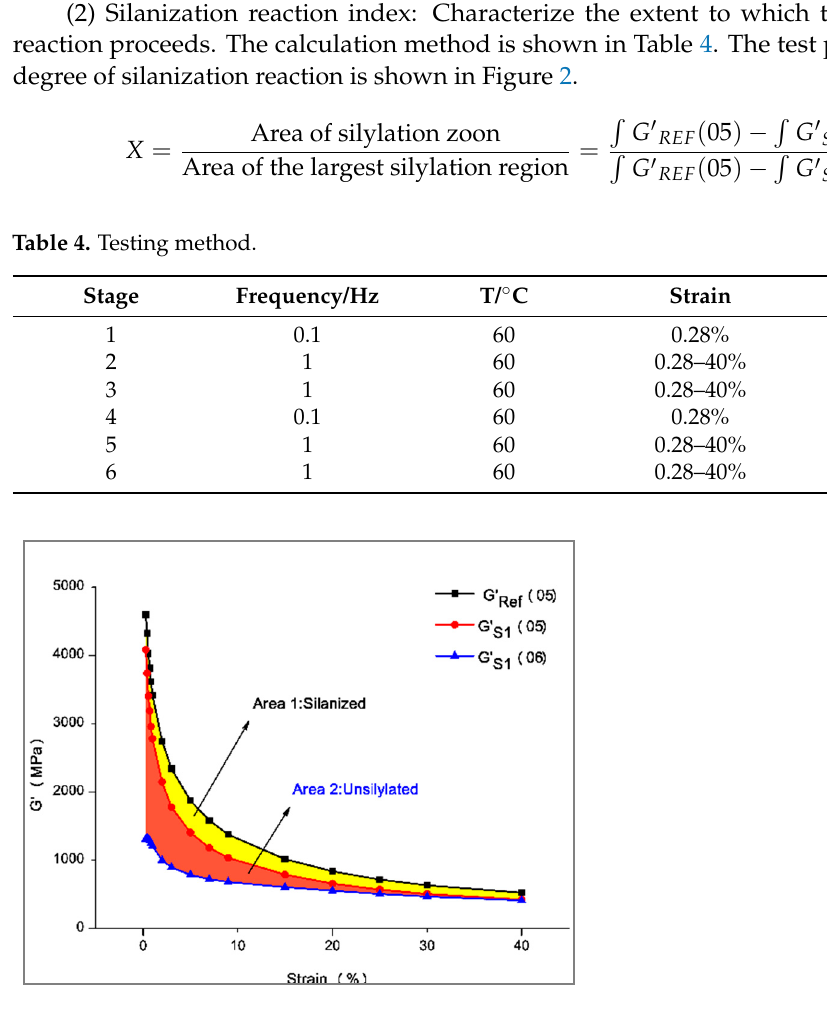
Figure 2. Distribution of silanization reaction degree.